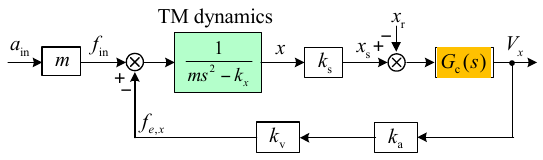
Figure 6. Block diagram of the closed-loop suspension control system used as a force-balanced electrostatic accelerometer: x r and x s are the position reference input and position sensor output used to evaluate the loop frequency response as defined in Equation (6).